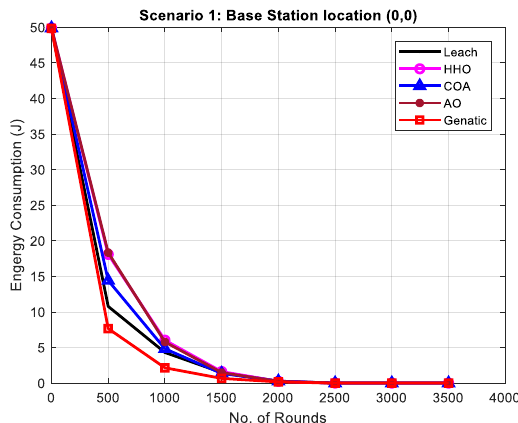
Figure 6. Energy Consumption in case of Scenario 1: Base station at (0,0).